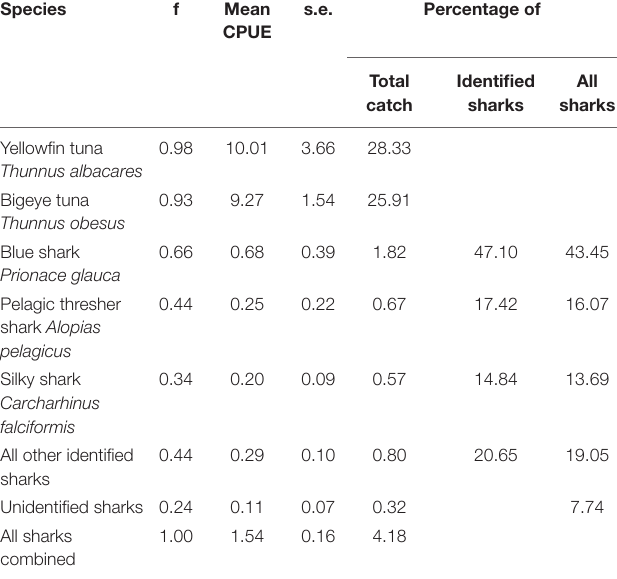
TABLE 4 | Summary table of the frequency (f), CPUE (Number caught per thousand hooks), standard errors (s.e.), and percentage contributions to catches for tunas and sharks from 41 longline sets surveyed as part of an observer run hook survey between November and February in 2000 to 2003 around the Chagos